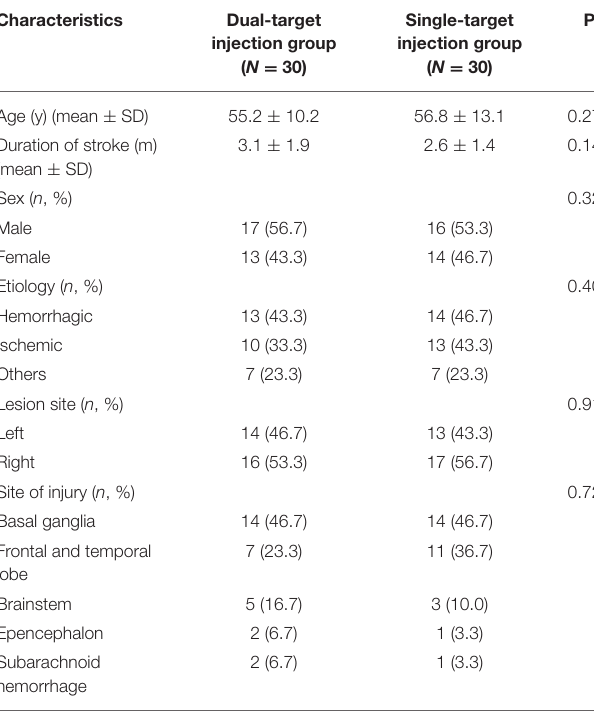
TABLE 1 | Baseline characteristics between the two groups. Characteristics Dual-target